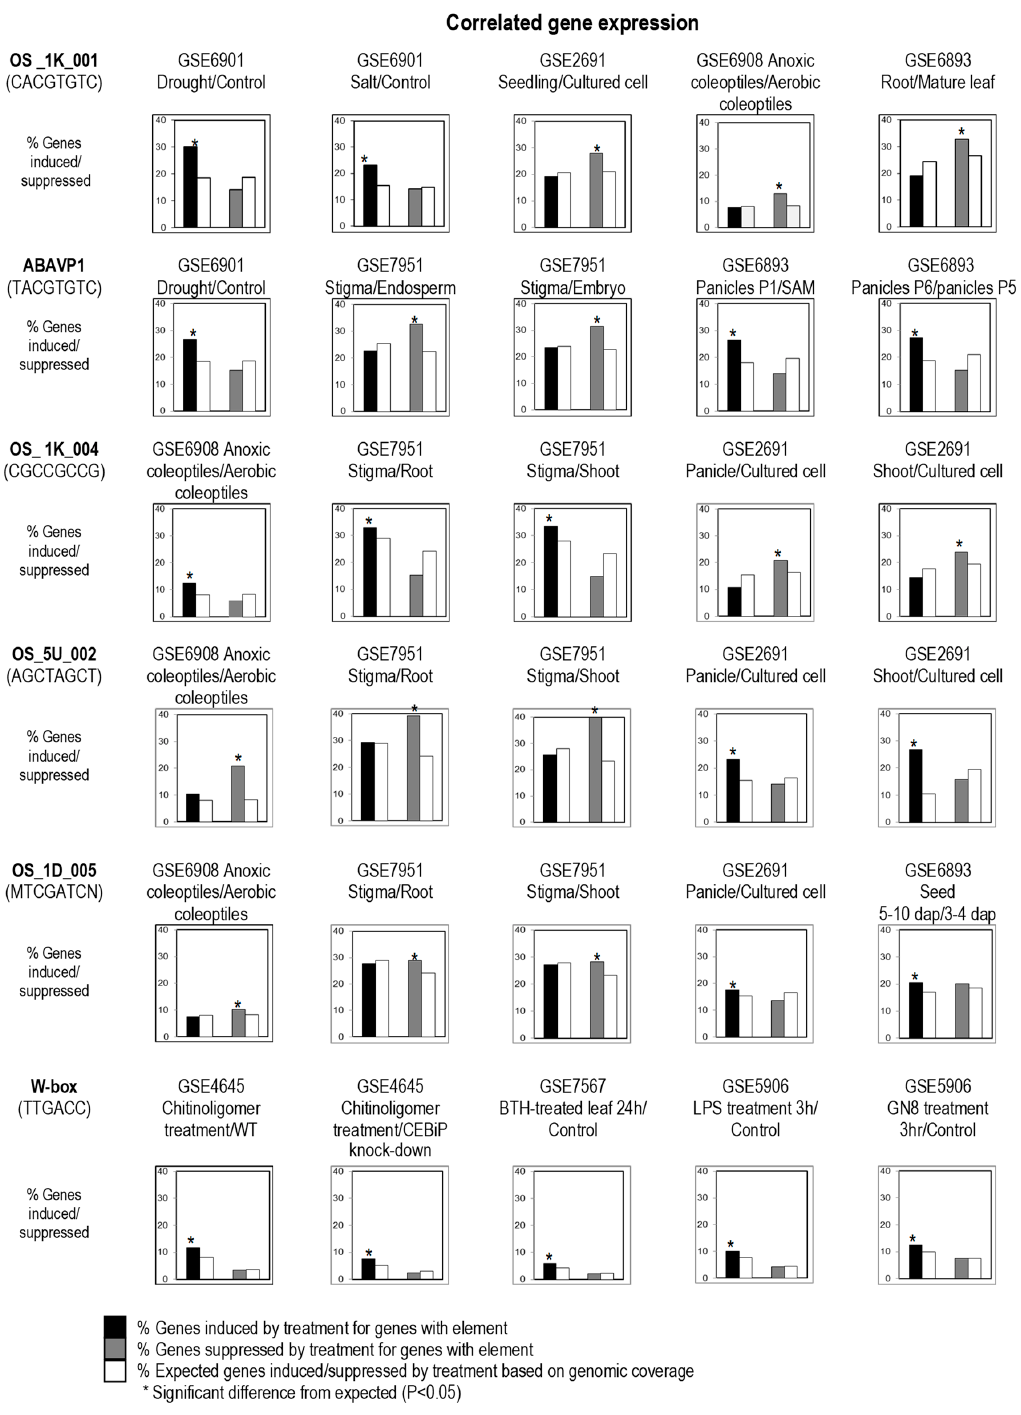
Figure 1. Regulatory fingerprints of cis-acting regulatory elements (CREs). Rice genes bearing predicted or known CREs were scored as either two-fold induced, two-fold suppressed, or neutral by pair-wise comparison of gene expression under two test conditions indicated above each bar chart. As a test of CRE function, the population of genes with the CRE was considered responsive to the test conditions if a significantly (*; p < 0.05) greater number of genes were induced (black bars) or suppressed (grey bars) than that expected by chance (white bars). SAM, shoot apical meristem; P1, panicles at 0–3 cm; P5, panicles at 15–22 cm; P6, panicles at 22–30 cm; dap, days after pollination; BTH, benzothiadiazole; GN8, N-acetylchitooligosaccharide; and LPS, lipopolysaccharides.